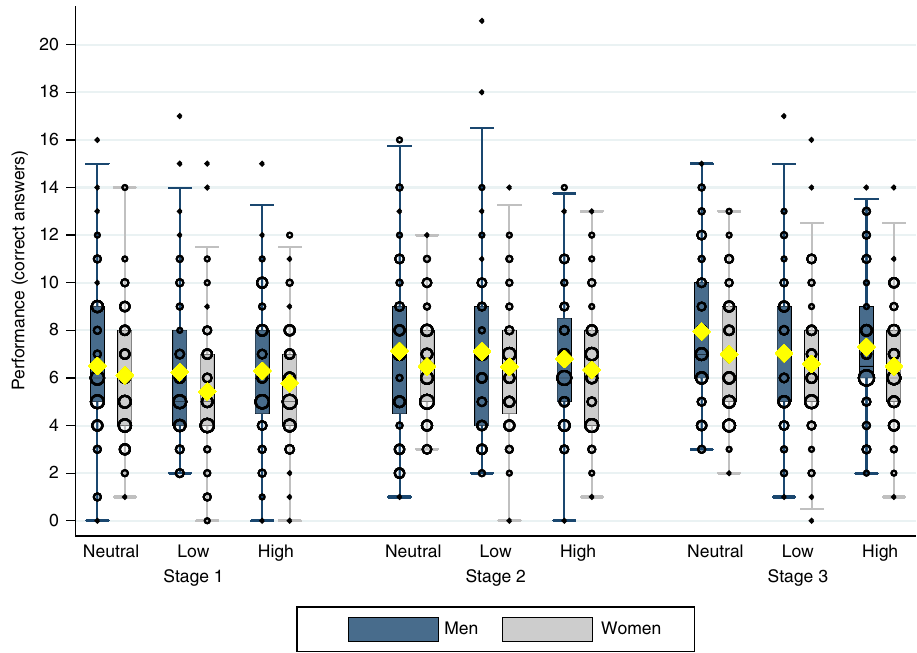
Fig. 1 Performance in the real effort task, by gender, stage, and priming condition ( n = 401). Box plots show the mean (indicated by yellow diamond signs), the 25th and 75th percentiles, Tukey whiskers (median ± 1.5 times interquartile range), and individual data points. Larger dots indicate a higher number of participants with the corresponding